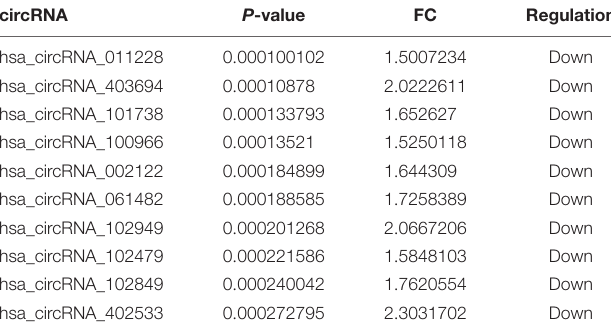
TABLE 3 | Top 10 downregulated